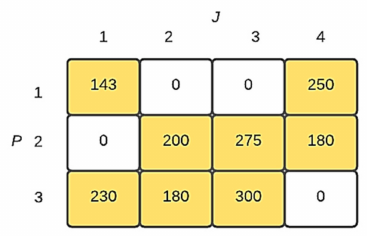
Figure 4. Product demand and destination